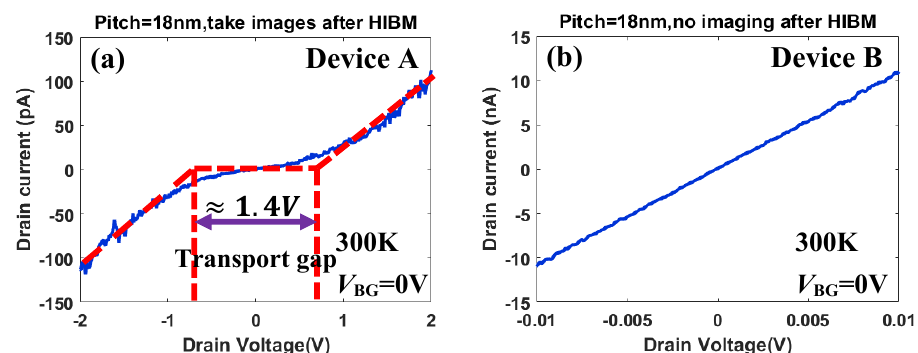
Figure 7. ( a ) The drain voltage ( V D ) dependence of the drain current ( I D ) with fixed back gate voltage ( V BG ) of 0 V at 300 K for GNM device A at 300 K. The transport gap was observed clearly due to the imaging after HIBM. ( b ) The V D dependence of the I D with fixed V BG of 0 V at 300 K for GNM device B. No transport gap was observed due to no imaging after HIBM.